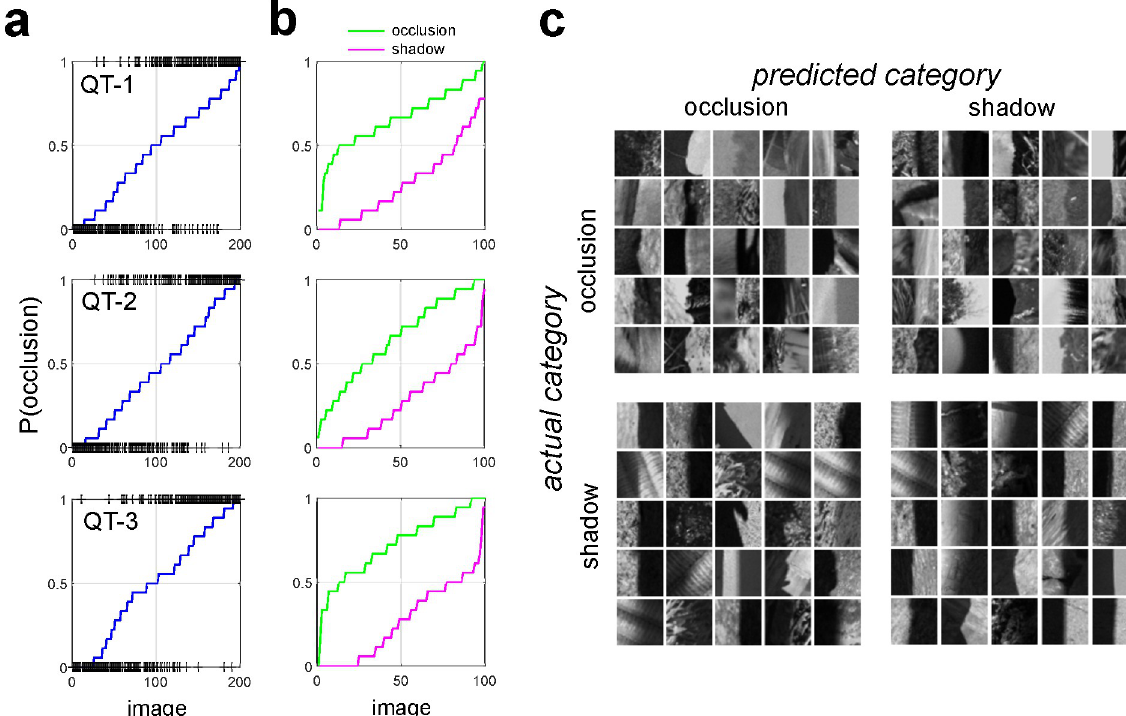
Fig 11. Human performance on individual images. ( a ) Predicted probability of being an occlusion edge by the AO ( blue curve ). Image patches are sorted by their probability. Actual category is indicated by a (+). ( b ) Occlusion probability predicted by the AO for each occlusion edge ( green curve ) and each shadow edge ( magenta curve ), sorted by occlusion probability. ( c ) Patches of each actual category which are most likely classified by human observers as the predicted category for QT-2 .